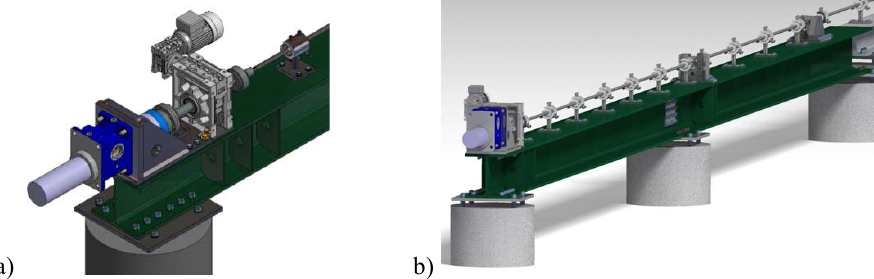
Fig. 1. Scheme of the Tensional-Torsional Hopkinson bar Hence, two distinct clamps are needed, as shown in Figure 2b; a former one is needed to contrast the torque, a latter one, which is adjacent to the input bar, is needed to contrast the axial load. Moreover, the two actuators are independently operated, so that any combination of static tension/torsion pre-loads can be applied. As aforementioned, the waves’ generation is triggered by the brittle failure of a sacrificial element that resists both axial and torsional static preload, until its maximum strength is exceeded by the applied